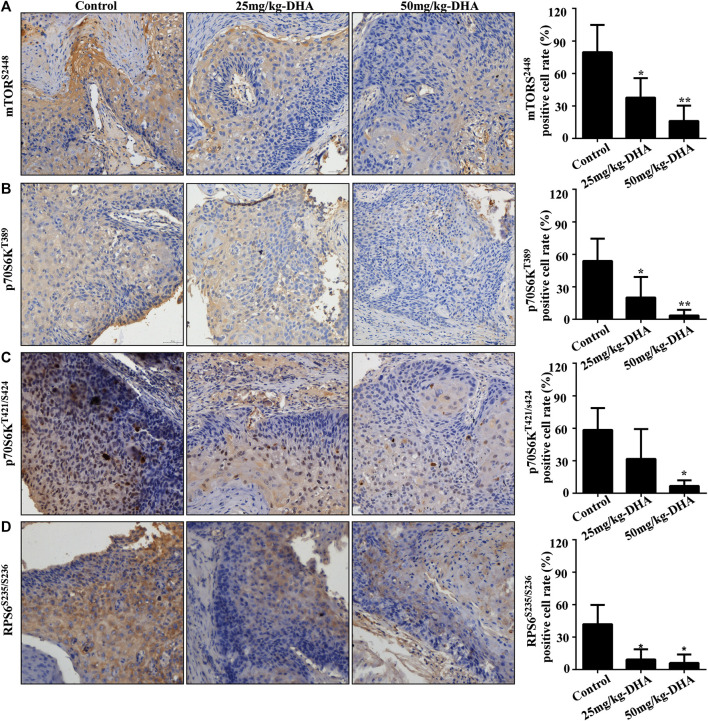
DHA suppresses the phosphorylation of mTORS2448, p70S6KT389, p70S6KT421/S424, and RPS6S235/S236 in the LEG20 xenograft mice model, confirmed using IHC analysis. (A–D) DHA inhibited the levels of mTORS2448
(A) p70S6KT389
(B) p70S6KT421/S424
(C) and RPS6S235/S236
(D) in the LEG20 xenograft tumors. Representative images of each group are shown. All the sections were scanned using TissueFAXS (400×), and the positive cells were analyzed using HistoQuest 4.0 software (*, p < 0.05; **, p < 0.01; ***, p < 0.001; n = 6 per group, one-way ANOVA).